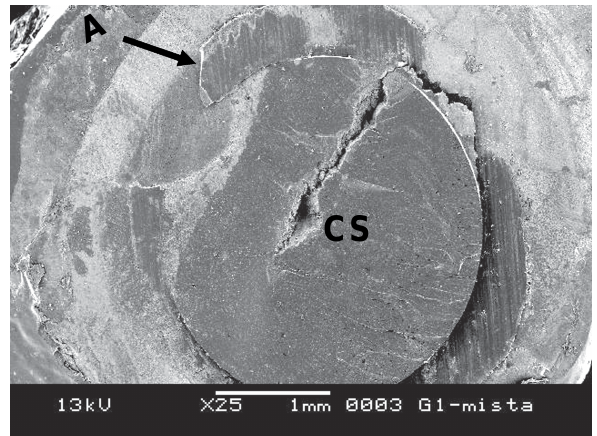
FIGURE 2- SEM photomicrograph illustrating a mixed failure for Group 6 (A – adhesive; CS – cohesive in